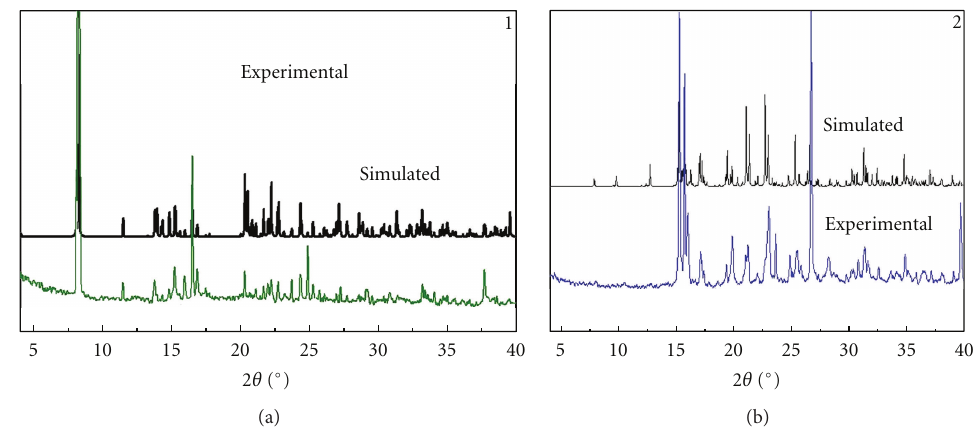
F 4: Experimental and simulated powder X-ray diffraction patterns of 1 (a) and 2 (b).